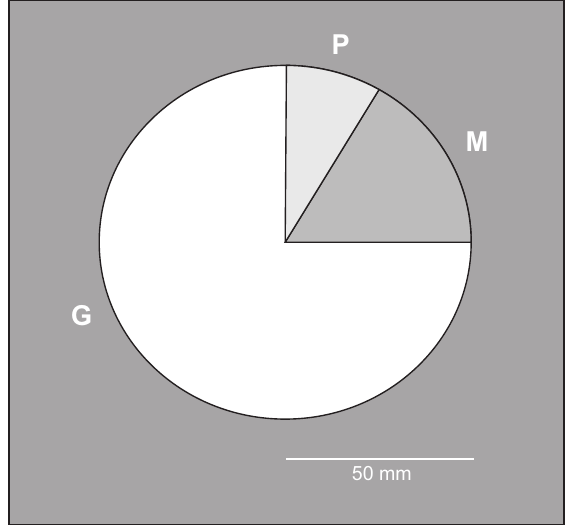
de tamanho das presas encontradas nos estômagos: presas pequenas (P) < 30º; presas médias (M) < 60º; presas grandes (G) > 60º. Raio do circulo igual a 50